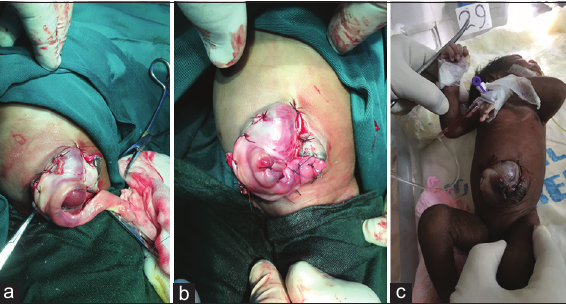
Figure 1: The operative technique and its result. (a) Spiral-like arrangement of the umbilical cord around